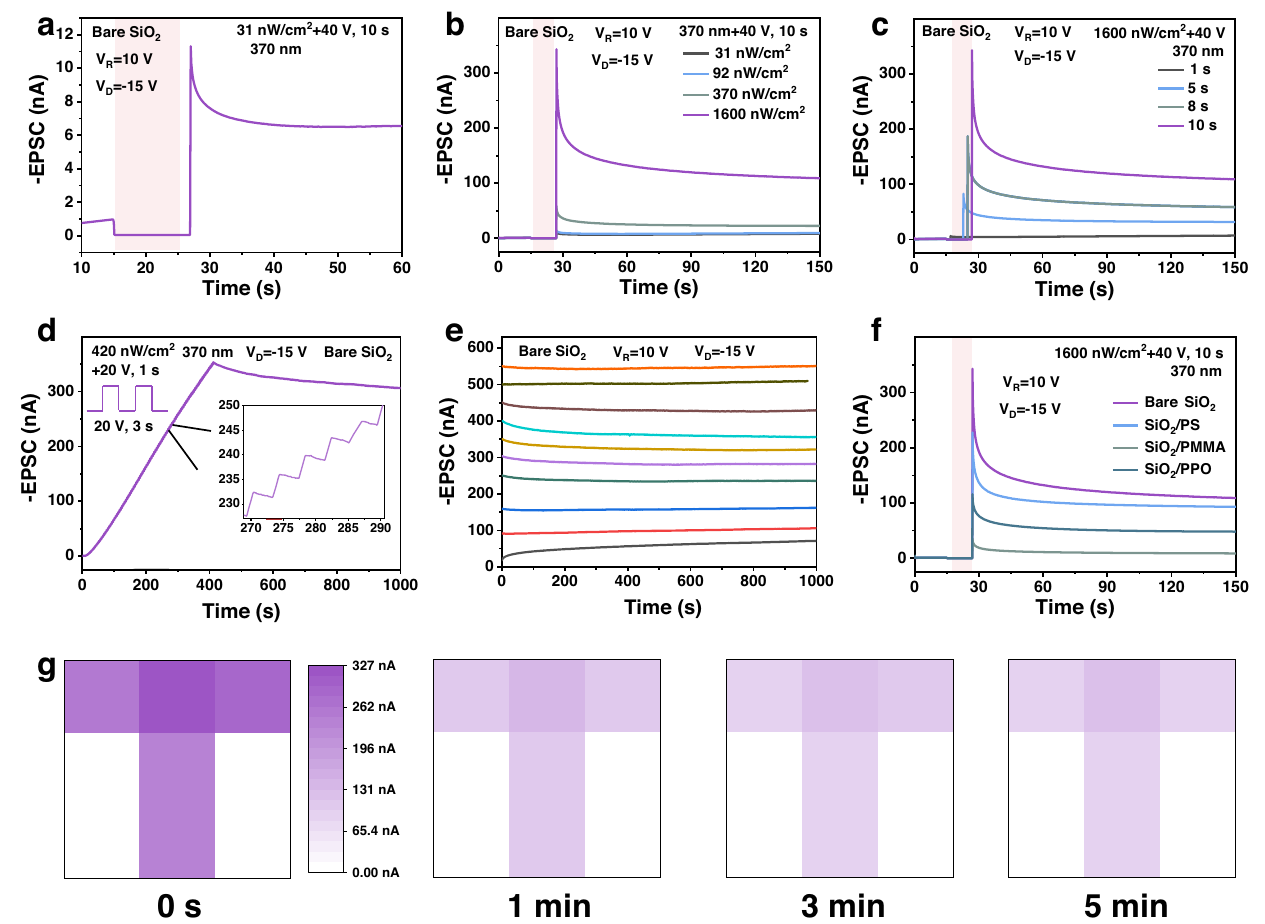
Fig.4|Synapticplasticityandimagememorization. EPSCofthebareSiO 2 device triggered by: a an ultraweak UV light spike; b various UV illumination intensities; c various pulse widths of UV light; d 100 consecutive UV presynaptic spikes. e The retentionpropertyofdifferentcurrentlevelsforthebareSiO 2 device. f EPSCofthe devices with different buffer layers. g Image detection and memorization of the